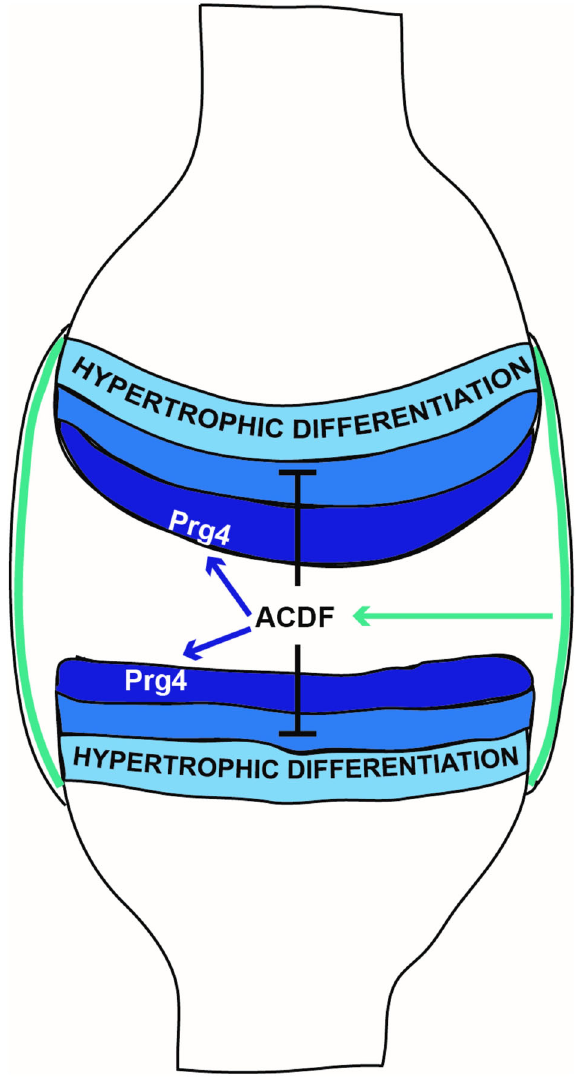
Fig. 10 Proposed model: Synoviocytes, via the secretion of articular cartilage differentiation factor (ACDF) affect chondrocyte differentiation at the joint surface. Schematic representation of proposed functional model. Synoviocytes in the synovial membrane (green) secrete articular cartilage differentiation factor(s) (ACDF) to the synovial fl uid. ACDF diffuse into the articular cartilage and inhibits hypertrophic differentiation in the super fi cial (dark blue) and intermediate zone (blue), but do not reach the deep zone (light blue) in suf fi cient concentration to block hypertrophic differentia- tion. ACDF also directly or indirectly induce Prg4 (lubricin) expression in the super fi cial zone. Synoviocyte-produced ACDF may thereby inhibit endochondral bone formation and support articular cartilage formation and maintenance at the joint